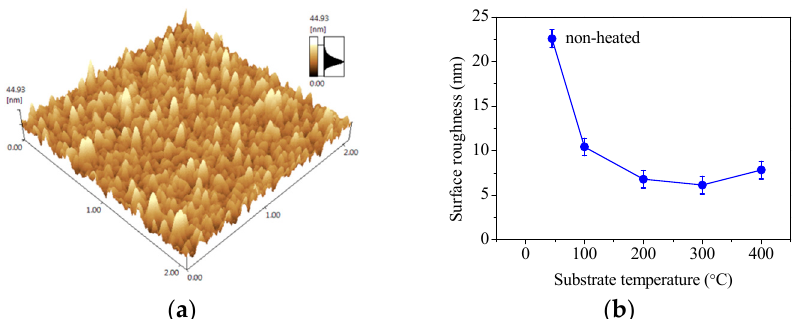
Figure 6. ( a ) Atomic force microscopy (AFM) image of an AlN:Er film deposited at 200 °C; ( b ) dependence of AlN film surface roughness on substrate temperature.